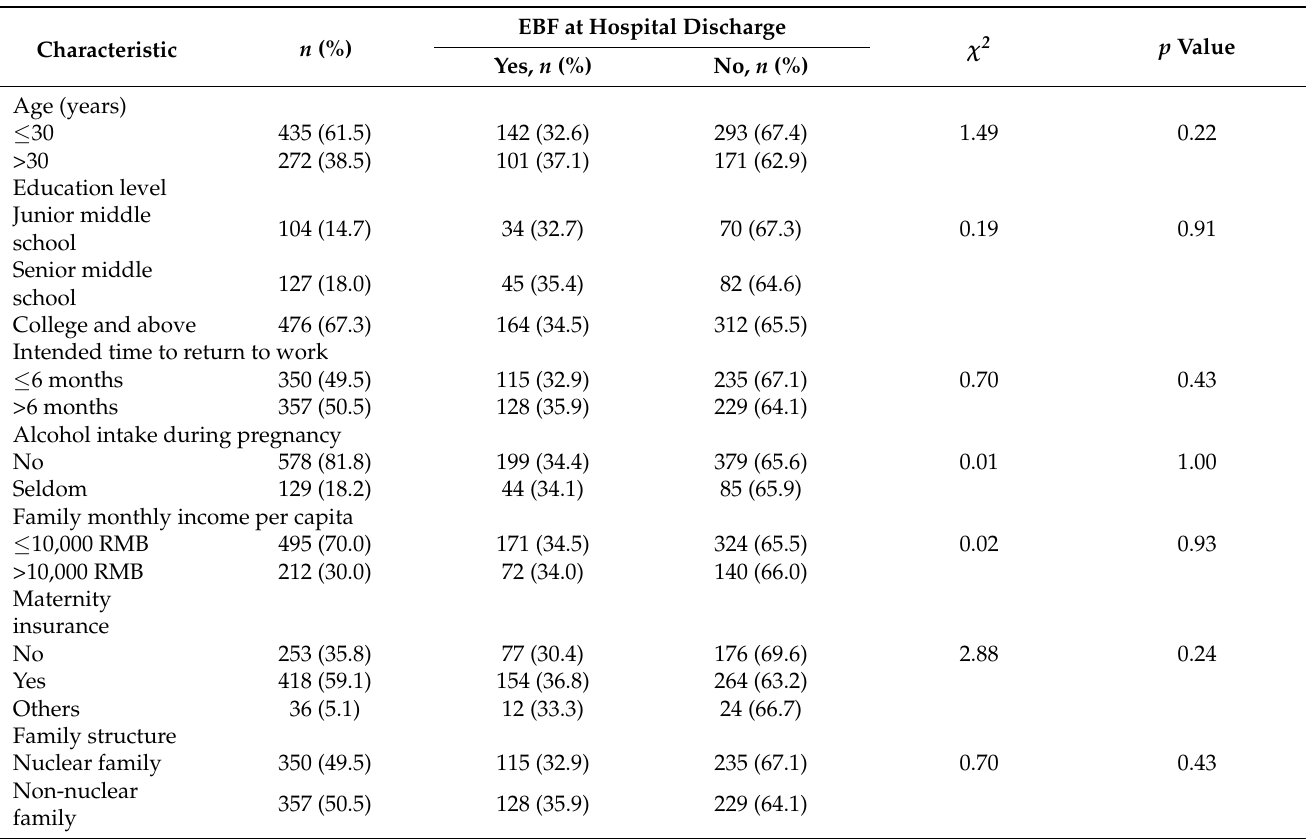
Table 1. Characteristics of participants and the associations with exclusive breastfeeding (EBF) at hospital discharge ( n =